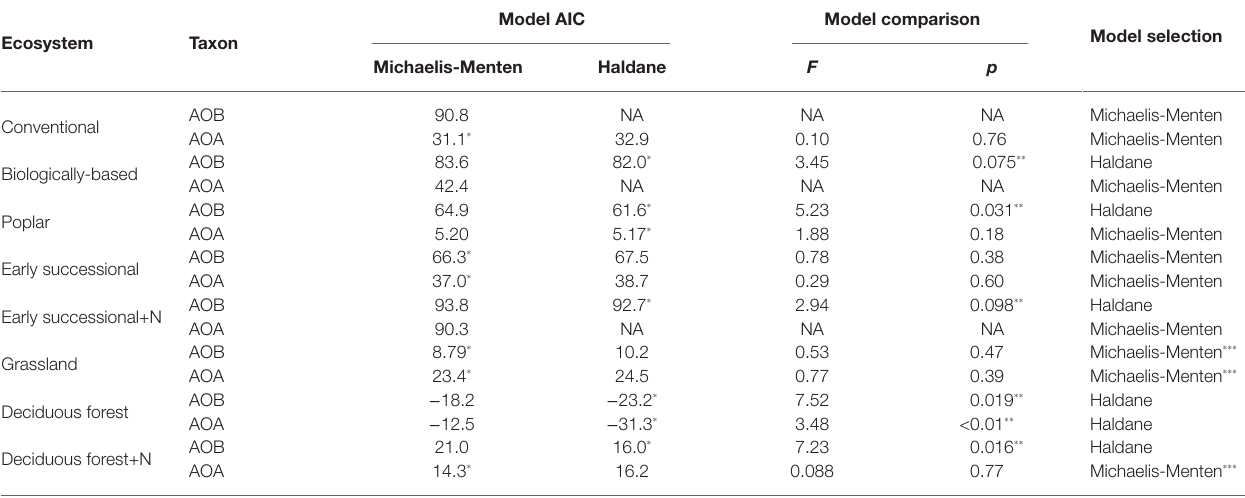
TABLE 1 | Comparisons between Michaelis-Menten and Haldane kinetics models for ammonia oxidizing bacteria (AOB)-derived or ammonia oxidizing archaea (AOA)- derived nitrification rates among different ecosystems; ecosystems followed by “+N” indicate subplots receiving long-term N fertilizer. Model AIC Model Ecosystem Taxon